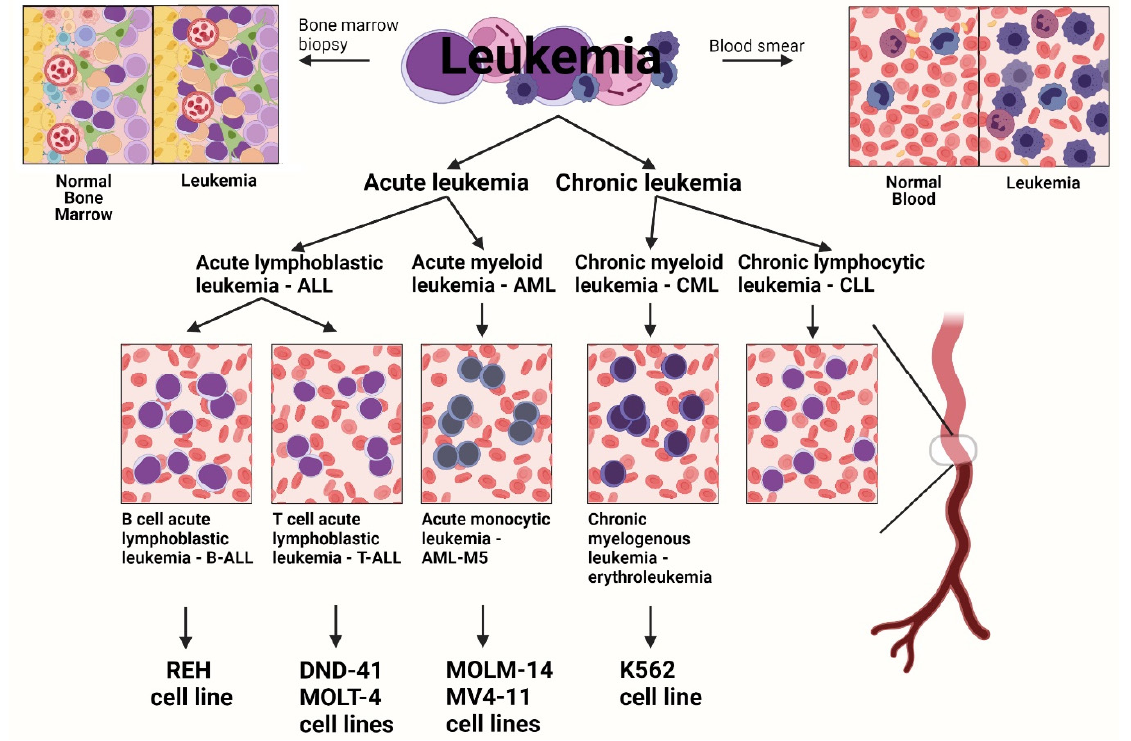
Figure 1. The different types of human leukemia cell lines. (Created with BioRender.com, accessed on 14 January 2022).